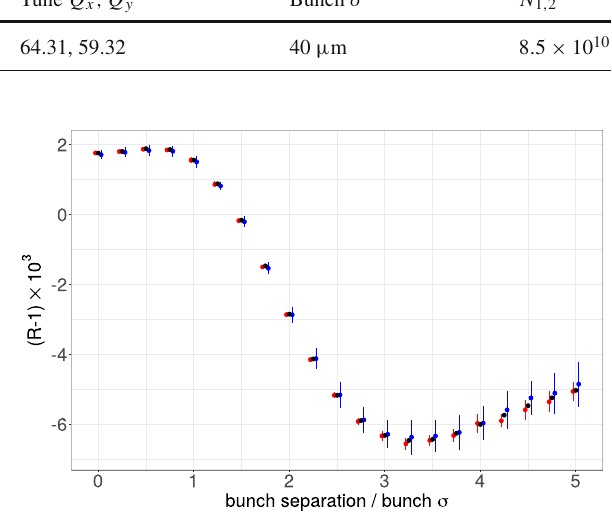
Fig. 5 The deviation of the ratio R defined in (3.20) from unity in per mille in the x -scan versus the separation of the bunches expressed in the bunch widths. The beam parameters are taken from Table 1. The error bars show the standard deviation of the results when the simulation was repeatedwithdifferentrandomseeds100and25timesforinstantaneous (blue)andadiabatic(redpoints)switchofthebeam–beamforce,respec- tively. The number of simulated turns are [ N no BB turn , N adiab turn , N BB turn ] = [ 100 , 0 , 500 ] (blue), [ 100 , 100 , 500 ] (red), [ 10000 , 10000 , 1000000 ] (black). The red and blue points are displaced horizontally to the left and right, respectively, to reduce overlapping = 1000, N adiab = 1000 and N BB = ues, N no BB turn turn turn